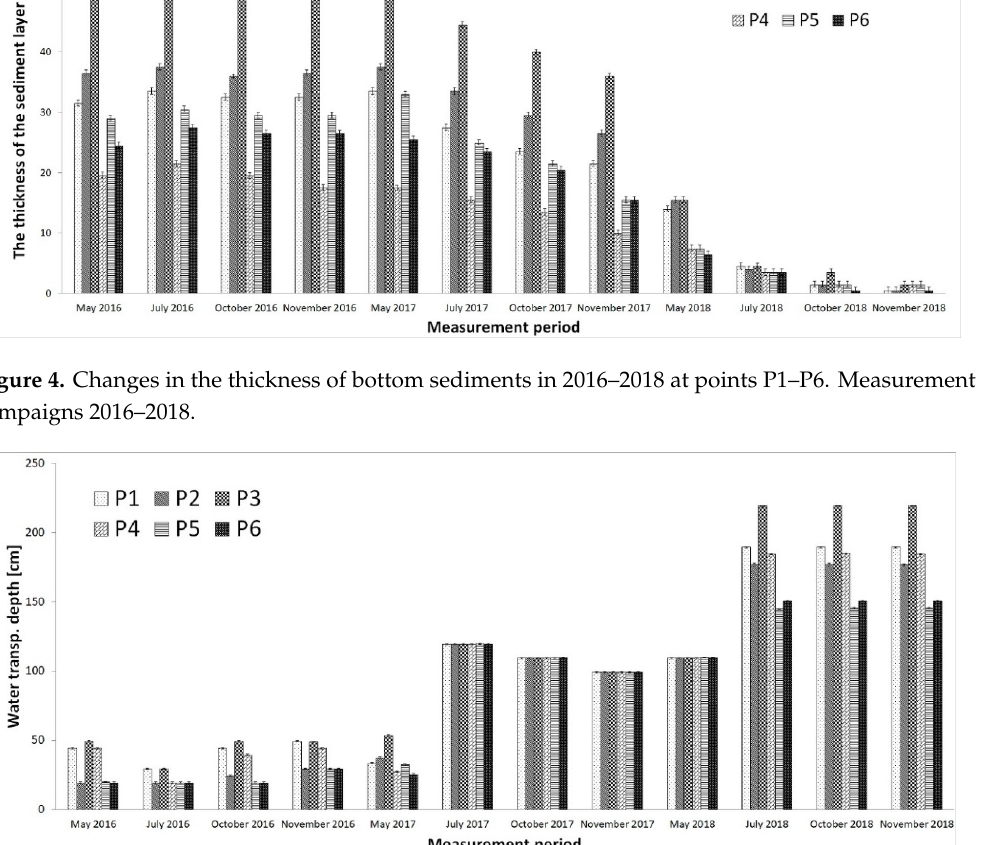
Figure 4. Changes in the thickness of bottom sediments in 2016–2018 at points P1–P6. Measurement campaigns 2016–2018.